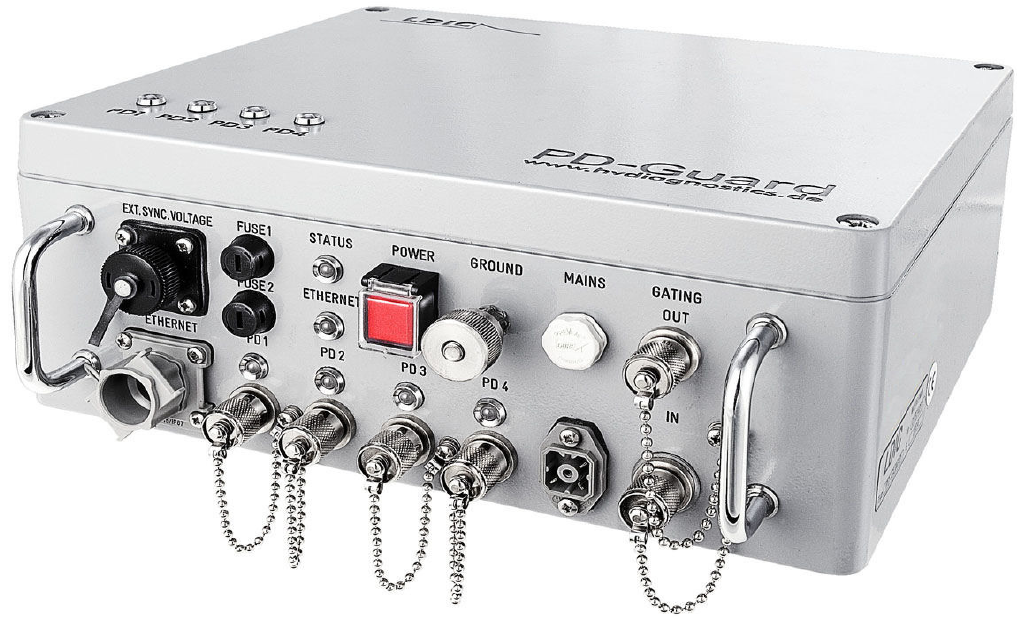
Fig. 5. (Color online) Calibrator.